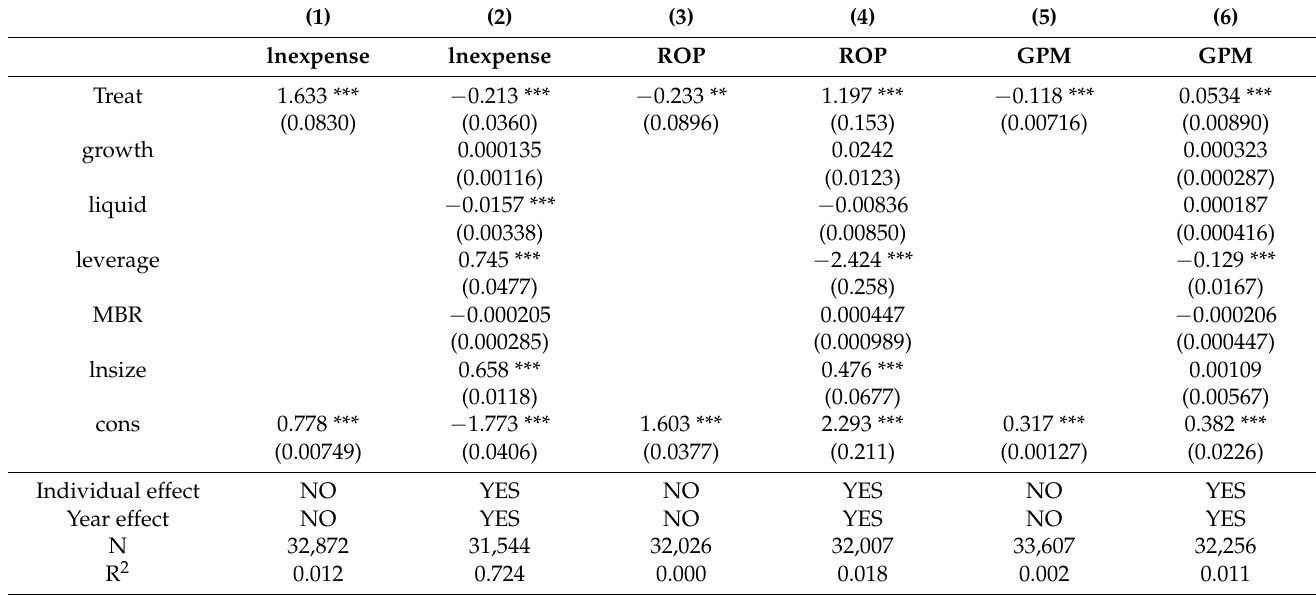
Table 10. Results of mechanism